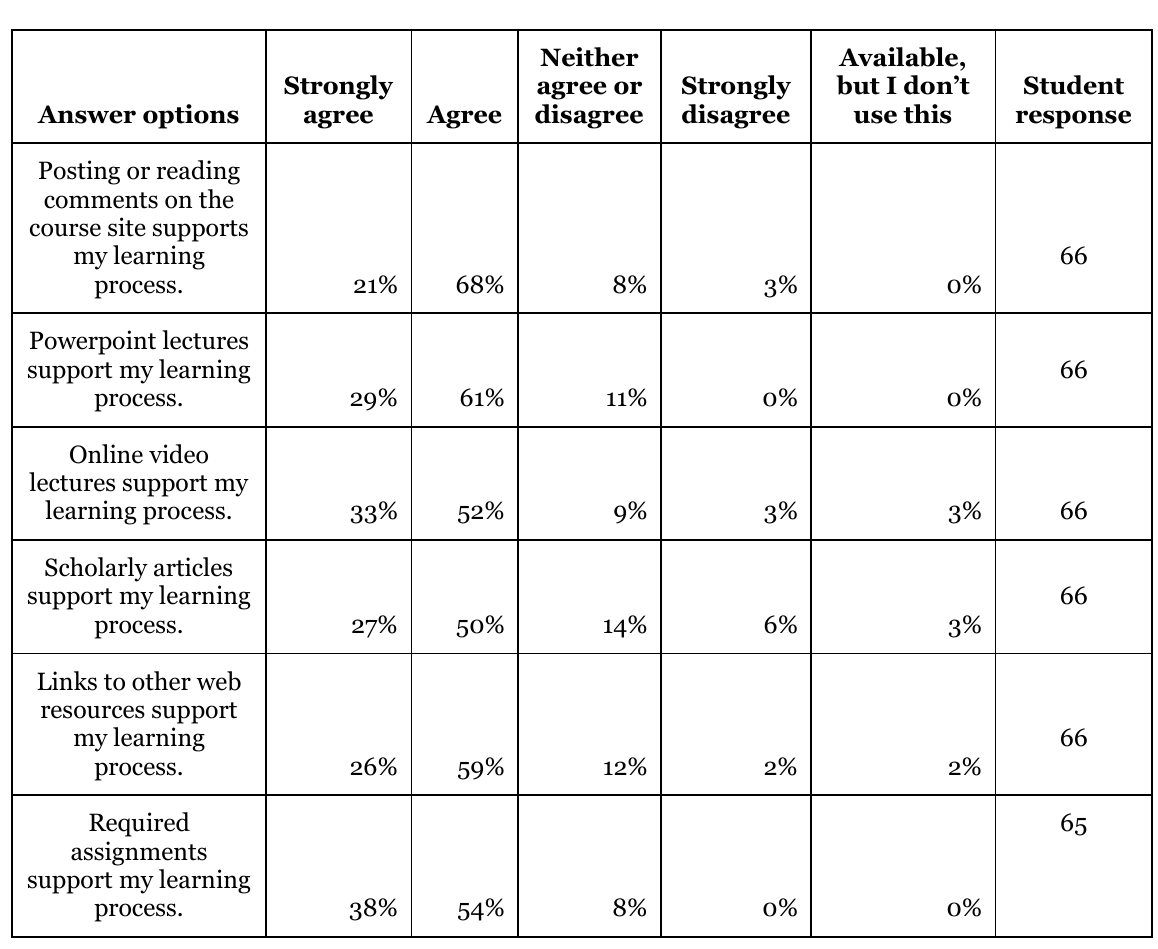
Level of Agreement About Course Materials From the OER That Supported the Learning Process (n=66)